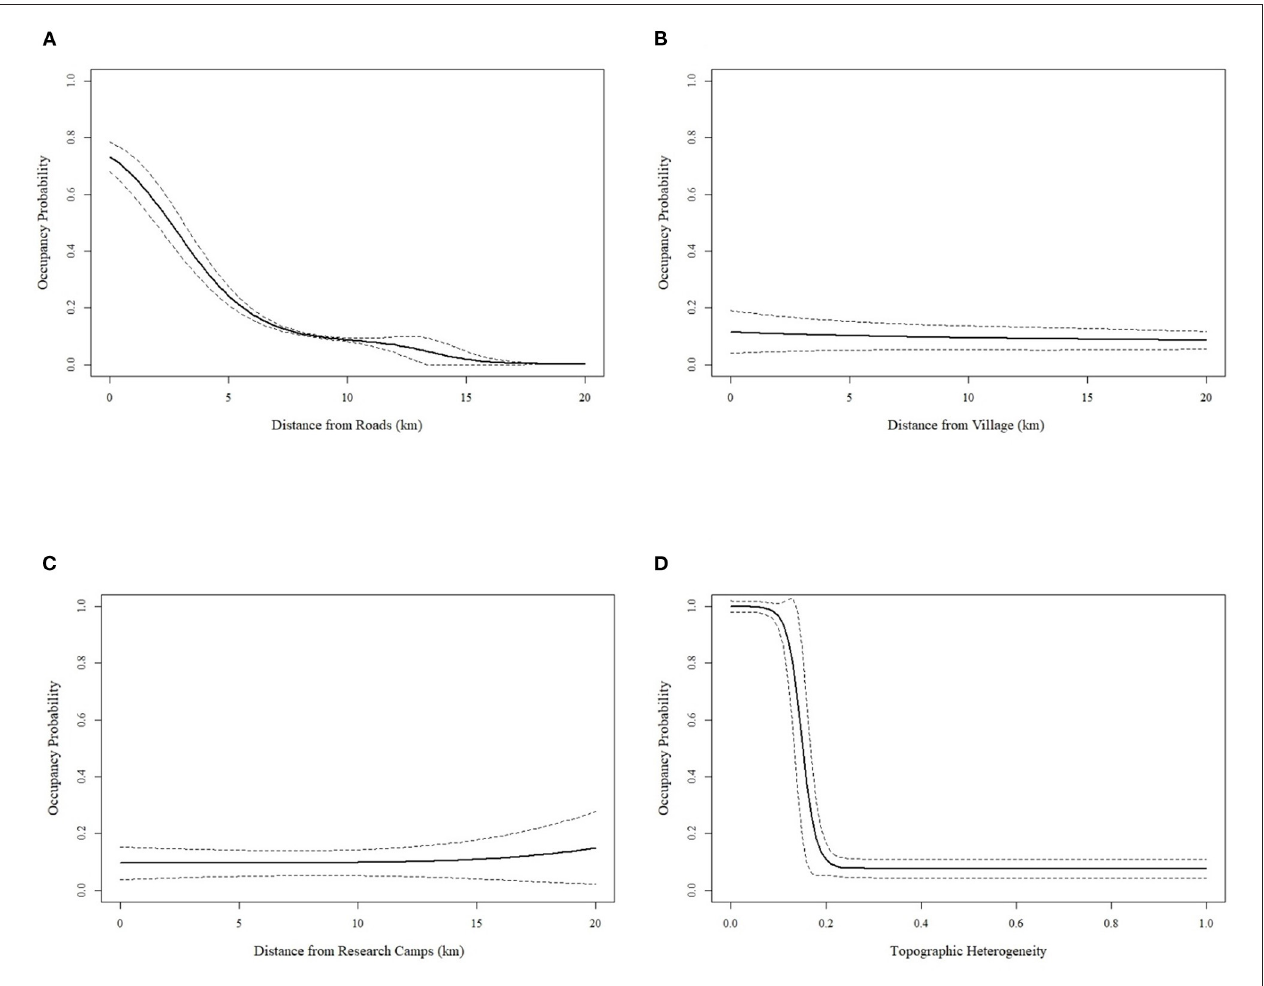
FIGURE 4 | Probability ( ± 95%) of hunting occupancy as a function of distance to road (A) , distance to village (B) , distance to nearest research camp (C) and topographic heterogeneity (D)